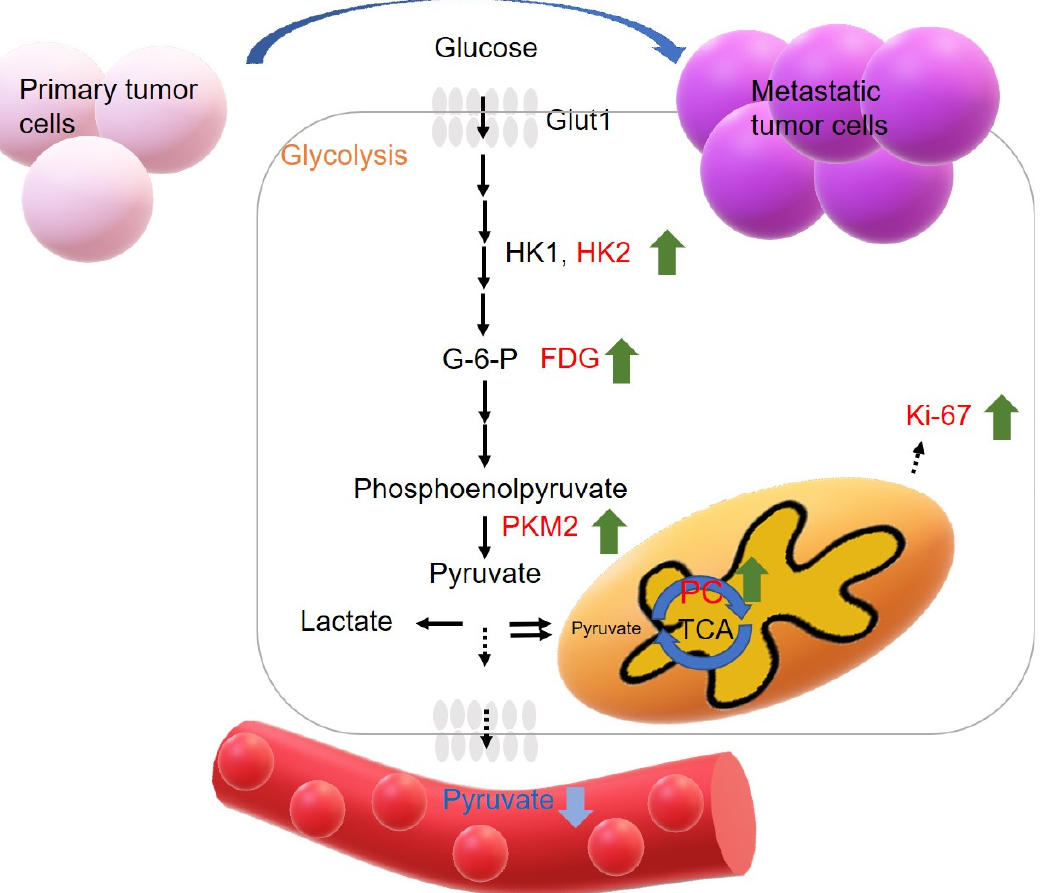
Figure 1. The hypothesis of metabolism alternation in the progression of metastasis. Tumor needs to acquire a large amount of energy for expansion and invasion. Elevated glycolysis and active TCA (tricarboxylic acid) cycle produce ATP (adenosine triphosphate) and metabolites that metastatic tumor cells need. Meanwhile, the metabolites, pyruvate released from the cell into the circulatory system would be decreased due to the catalyzation of pyruvate in tumor cells.